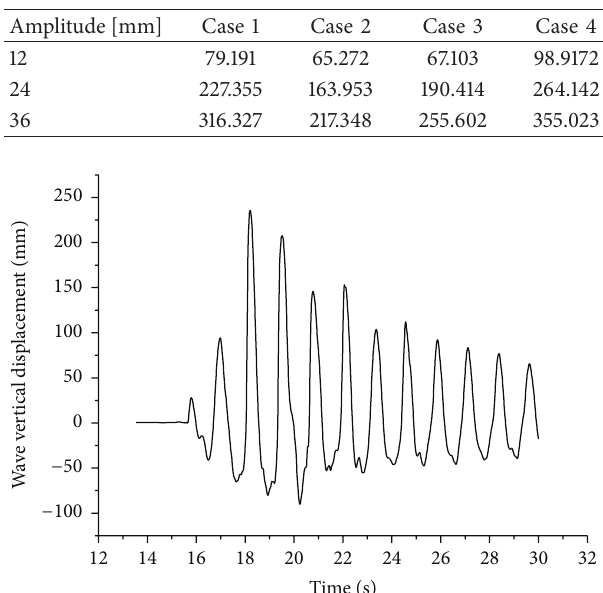
Table 3: The maximum wave height.